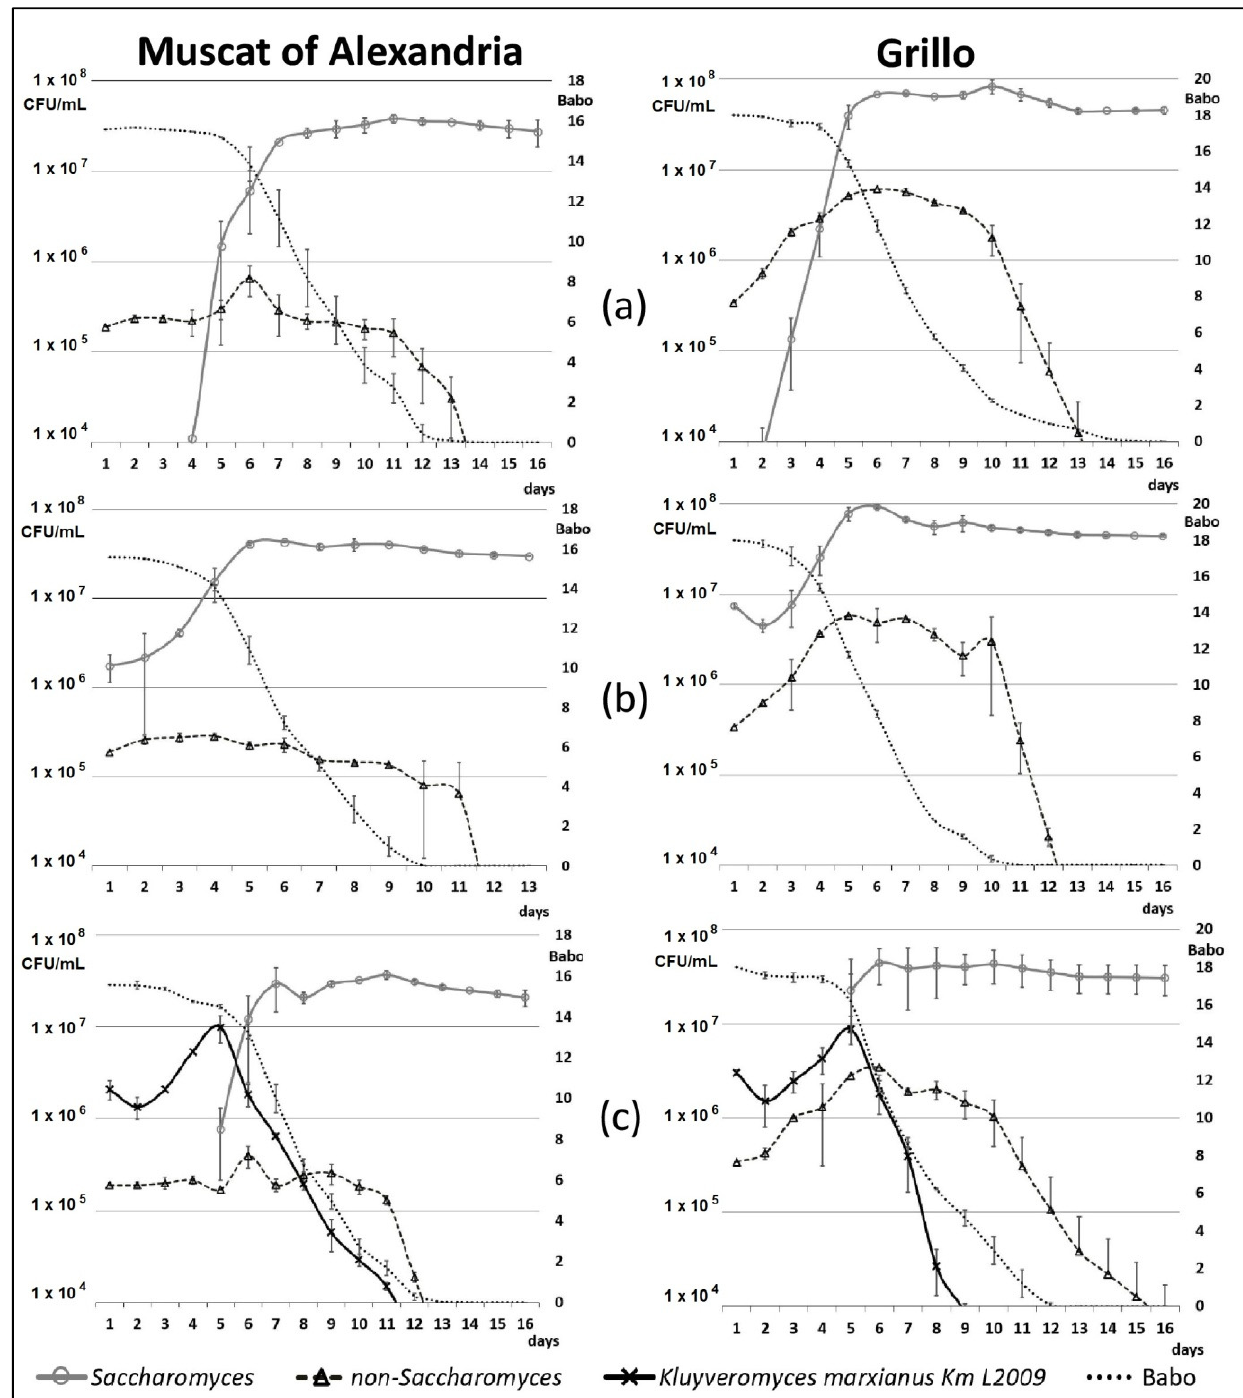
Figure 4. Growth curve of Kluyveromyces marxianus strain Km L2009, Saccharomyces and other non- Saccharomyces yeasts in vinifications of Muscat of Alexandria ( left ) and Grillo ( right ) musts, with no starter inoculum ( a ), with Saccharomyces cerevisiae strain QA23 ( b ), and with K. marxianus Km L2009 ( c ) inoculum.